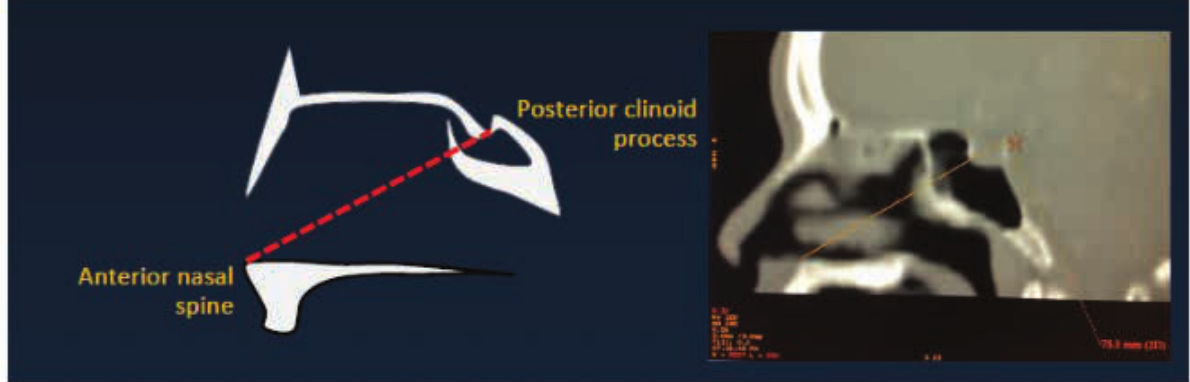
Figure 1: Measurement of the linear distance between the anterior nasal spine and the posterior clinoid process on Advantage Workstation 4.4.